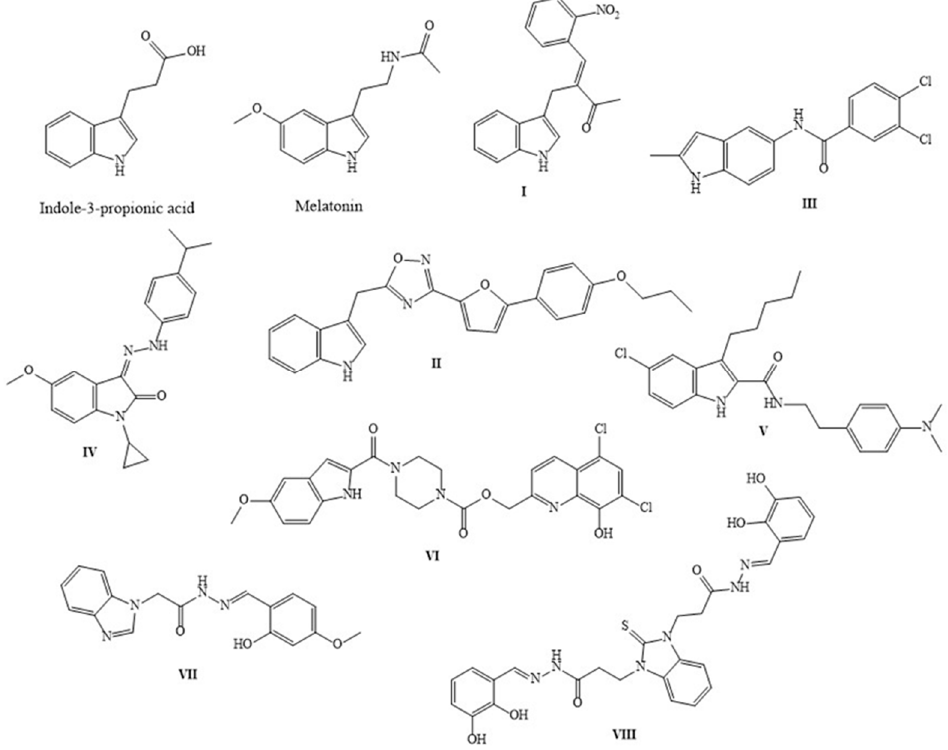
Scheme 1. Chemical structures of indole derivatives with versatile activity for the treatment of neurological conditions. neurological